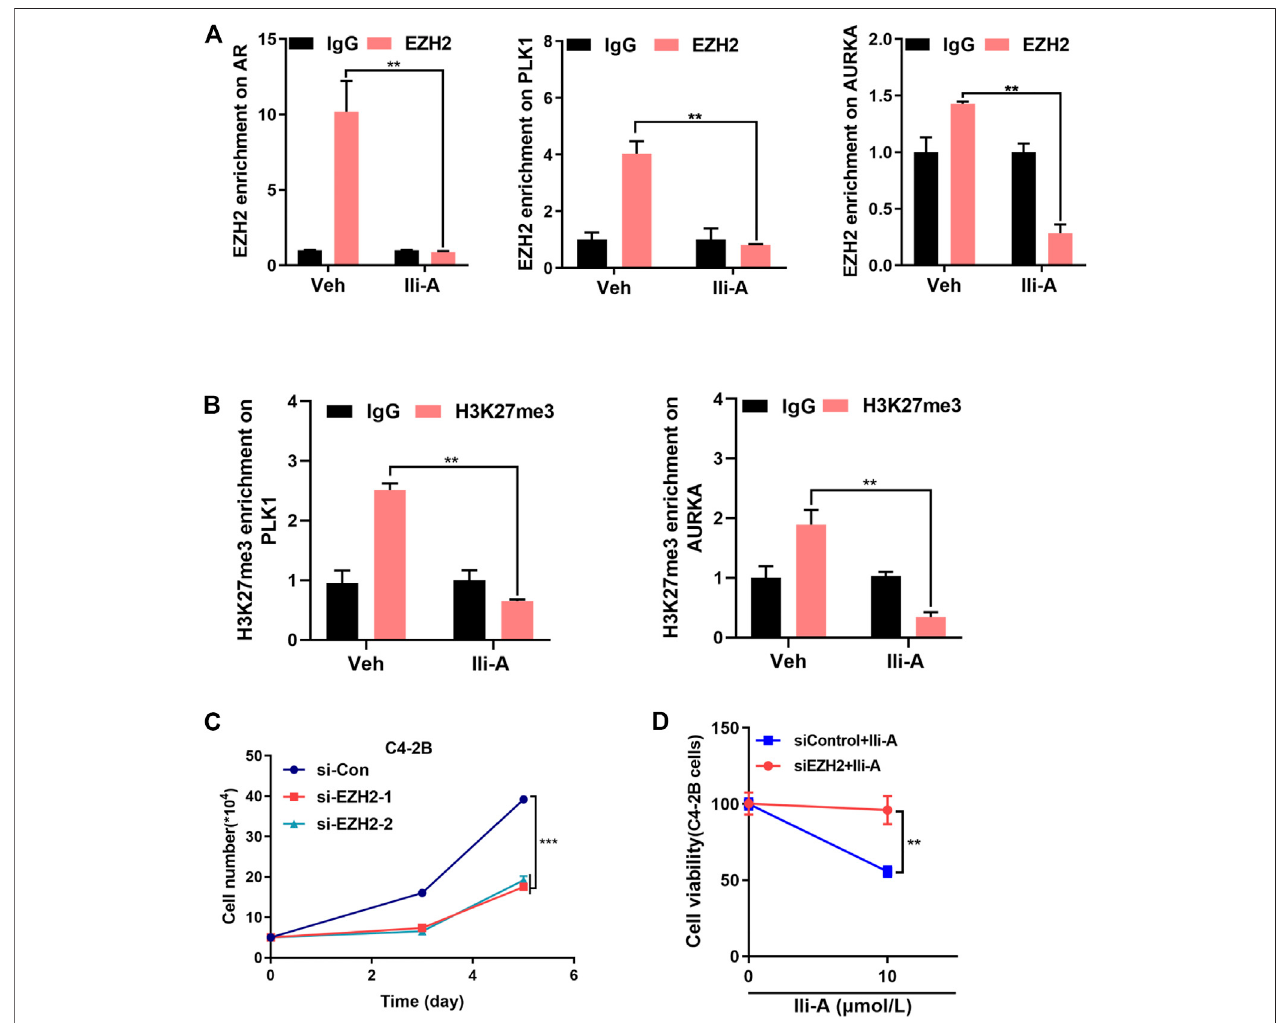
FIGURE 4 | Ili-A decreases expression of EZH2 target genes by inhibiting EZH2 expression. (A) ChIP-qPCR of the relative enrichment of EZH2 at AR , PLK1 and AURKA promoters in C4-2B cells treated with vehicle or Ili-A for 48 h (bottom) . “ Fold change ” denotes the indicated enrichment of AR , PLK1 , and AURKA under the in fl uenceofIli-AcomparedwithIgGenrichmentincellstreatedwithvehiclecontrolsetas1. (B) ChIP-qPCRoftherelativeenrichmentofH3K27me3at PLK1 and AURKA promotersin C4-2B cellstreatedwithvehicleorIli-A for48 h (bottom) . Fold changedenotes the indicated enrichment on PLK1 and AURKA under thein fl uenceof Ili-AcomparedwithIgGenrichmentincellstreatedwithvehiclesetascontrol. (C) C4-2BcellsweretransfectedwithEZH2orcontrolsiRNAfor72and120 h,andthetotal number of viable cells was counted with a cell counter. (D) C4-2B cells were transfected with EZH2 or control siRNA for 48 h and treated with vehicle or Ili-A for an additional 24 h. Cells were harvested to determine cell growth by counting the number of viable cells.